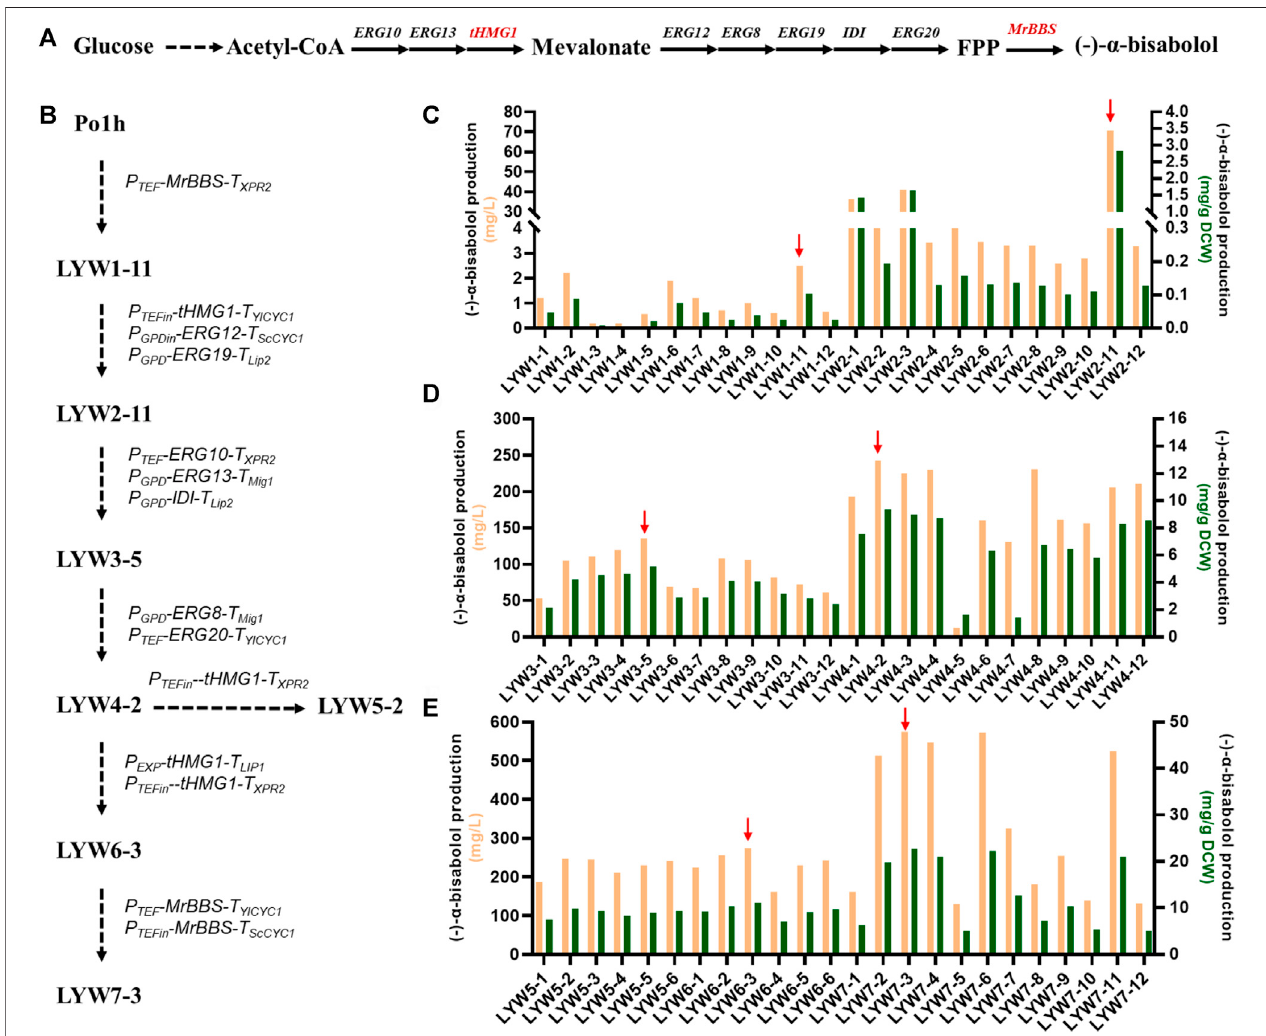
FIGURE 5 | Overproduction of (-)- α -bisabolol by optimizing the mevalonate pathway. (A) (-)- α -Bisabolol biosynthesis pathway. (B) Flow chart describing the construction ofengineered Yarrowialipolytica strains. (C) (-)- α -Bisabolol titer after randomlyintegrating MrBBS intoPo1h and tHMG1 aswell as ERG12 and ERG19 into LYW1-11. (D) (-)- α -Bisabolol titer after randomly integrating ERG10 , ERG13 , and IDI into LYW2-11 and ERG8 and ERG20 into LYW3-5. (E) (-)- α -Bisabolol titer after randomlyintegratingasinglecopyortwocopiesof tHMG1 intoLYW4-2andtwocopiesof MrBBS intoLYW6-3.Theredarrowindicatesthebest-performingstrain.